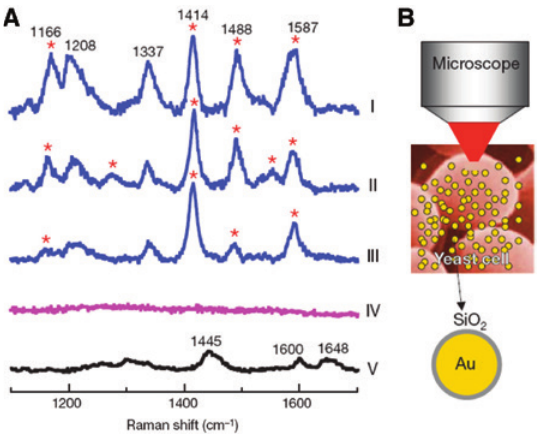
Figure 11: Schematic diagram shows that the biological structure of yeast cells is detected in situ by SHINERS. (A) Under this mechanism, the molecular Raman spectra (curves I–III) are obtained with different hotspots. In curve IV, there is no molecular adsorption substrate. Curve V shows the Raman spectra of yeast cells themselves. (B) Schematic of a SHINERS experiment on living yeast cells